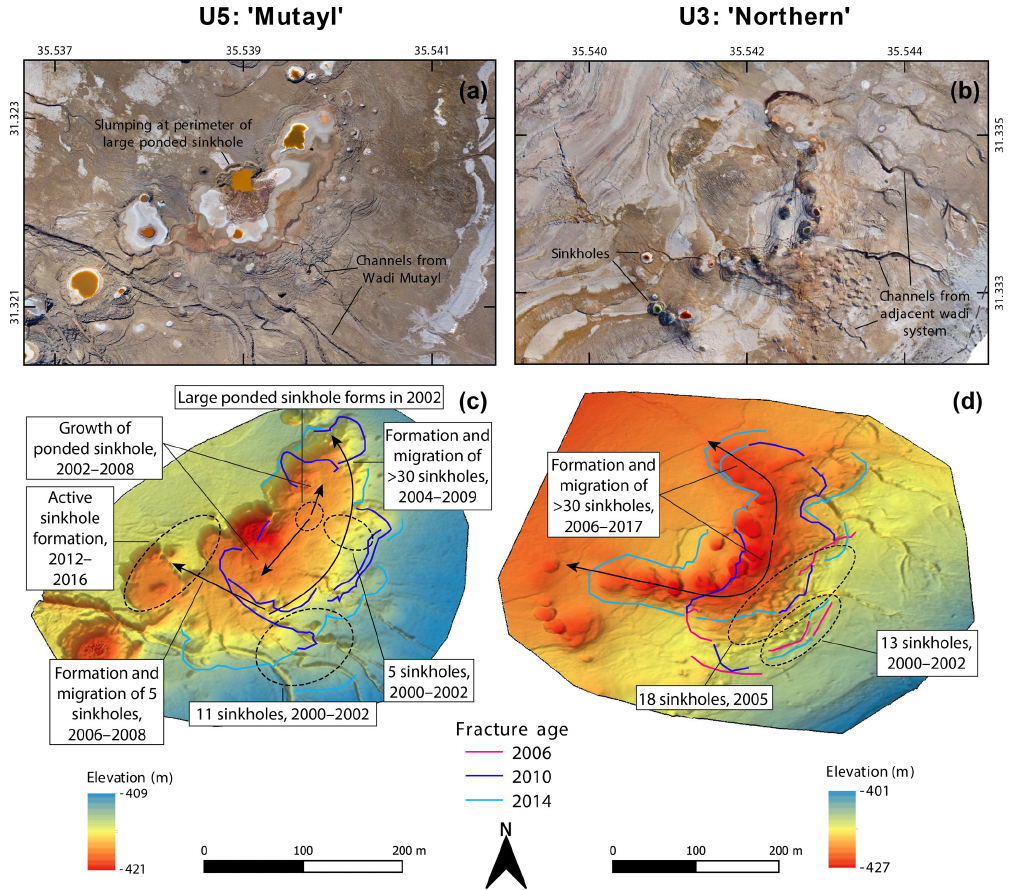
Figure 7. Structural development of uvalas U5 and U3 with unclear connection to subsurface water flow. See Fig. 4 for locations. Panels (a) and (b) show orthophoto images from 2016; Panels (c) and (d) show oblique 3-D views of the depressions derived from the 2016 DSM. The main depression-bounding fractures are shown, whose years of formation (i.e. when first visible in imagery) are coloured in 4-year